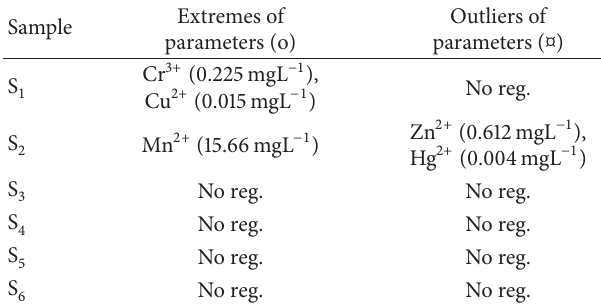
Table 5: Water samples with anomalous values (extremes